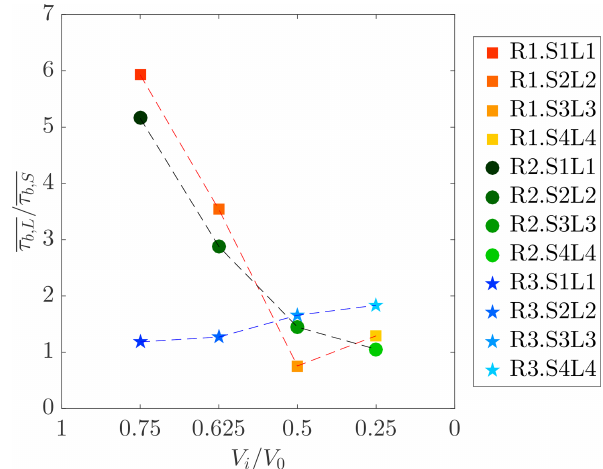
Figure 6. Ratio between time-averaged bed shear stress of tests with varying lock lengths ( τ b , L ) and test with varying lock slopes ( τ b , S ) versus percentage of volume of the upstream lock reach V i /V 0 . Dashed lines link tests performed with the same initial ex- cess density.